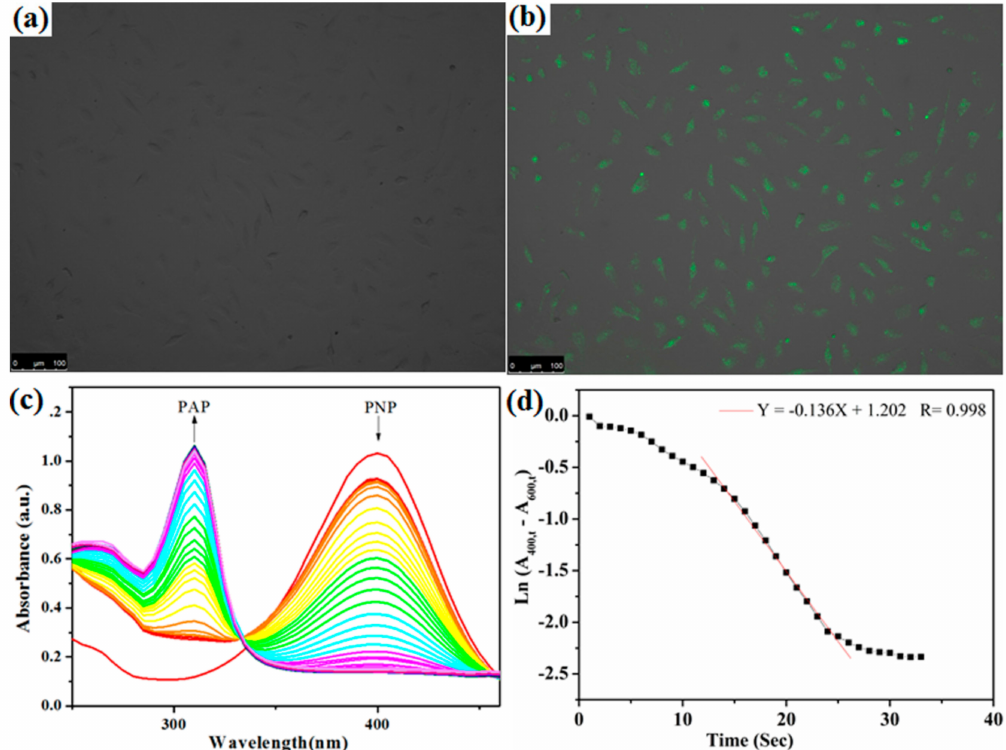
Figure 11. ( a , b ) Fluorescence micrograph of Hela cells incubated with CdTe / HPAMAM nanocomposites before ( a ) and after ( b ) excitation, showing the QDs aggregating in the cells. ( c , d ) Reduction of p -nitrophenol (PNP) catalyzed by Au / HPAMAM nanocomposites. ( c ) UV–Vis spectra with arrows indicating the decreasing absorbance at 400 nm (peak of PNP) and the increasing absorbance at 310 nm (peak of p -aminophenol (PAP)). ( d ) Plots of the natural log of corrected absorbance at 400 nm against